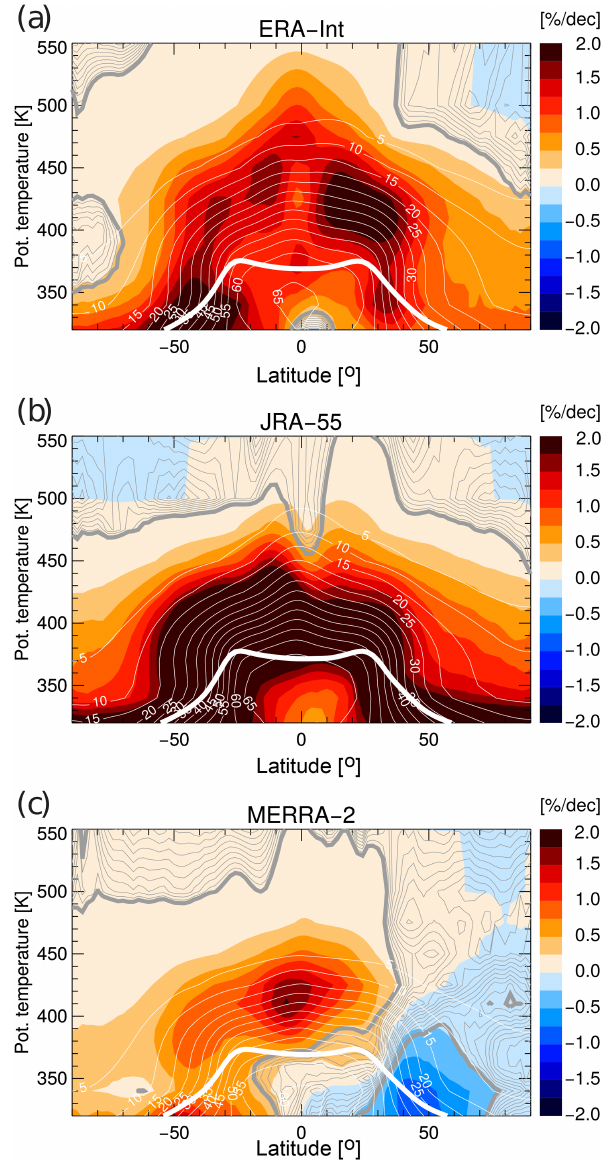
Figure 10. Trend in the young air mass fraction (transit time less than 6 months) from 1989 to 2015 for (a) ERA-Interim, (b) JRA-55 and (c) MERRA-2, in percent per decade. The white contours show the young air mass fraction climatology in percent, and the thick white line is the